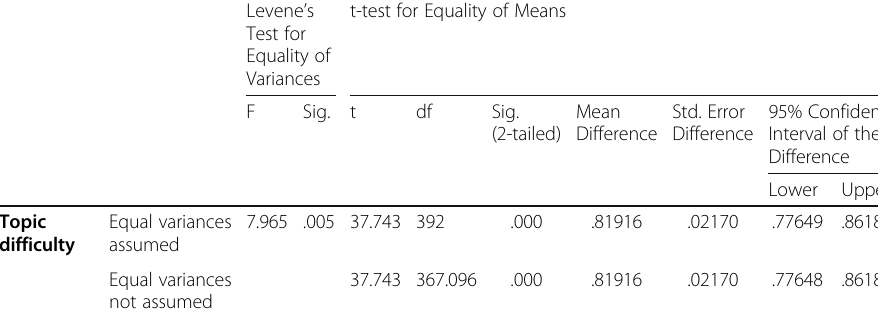
Table 14 The Results of T-Test to Compare the Results of Learners ’ Perception of Textbook- Assigned and Self-Selected Topics Regarding Topic Difficulty